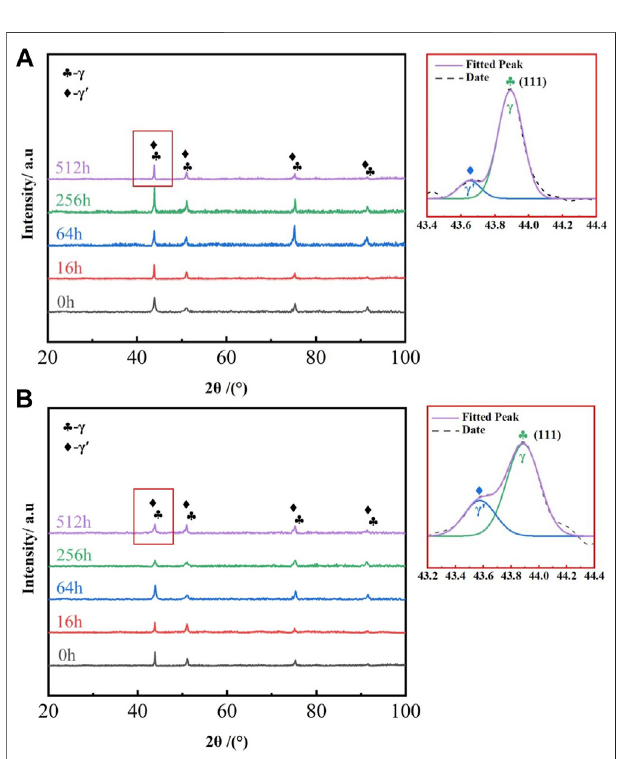
FIGURE 2 | XRD patterns of hot-rolled samples and after aging at 1073 K: (A) 2Cr, (B)